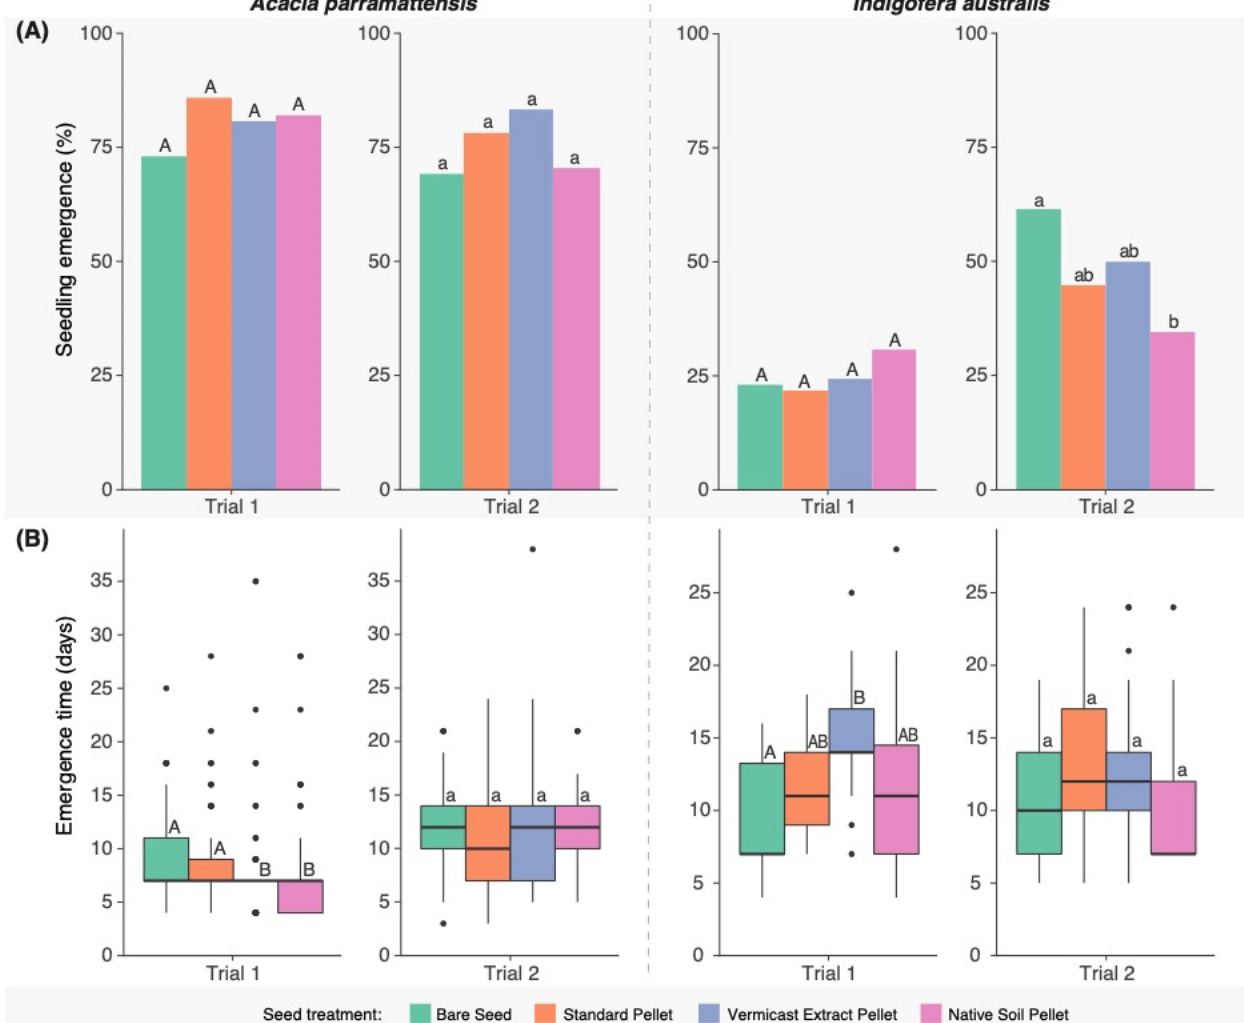
Figure 3. ( A ) Percentage of seeds of two native Australian plant species that emerged, and ( B ) time to emergence (days), from three pelleting treatments and bare seed controls. Emergence precents and mean emergence times without shared letters differ at p < 0.05 (ANOVA and Tukey test) within species and trials (upper- vs. lower-case letters).